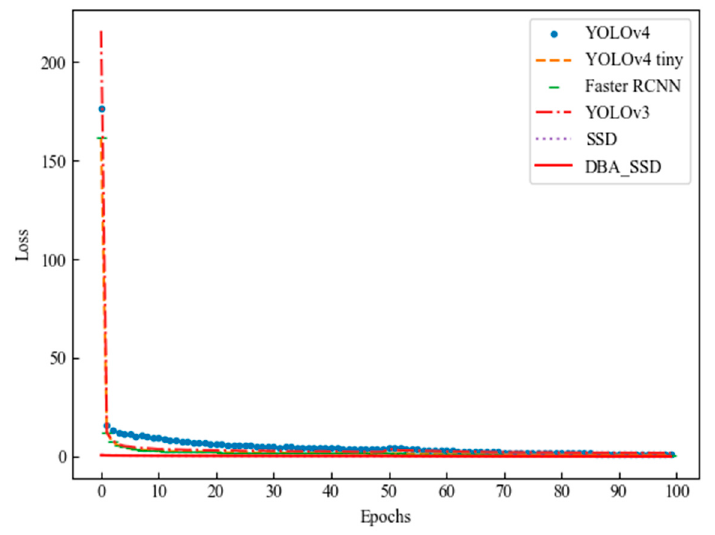
Figure 13. Target detection algorithm loss diagram.